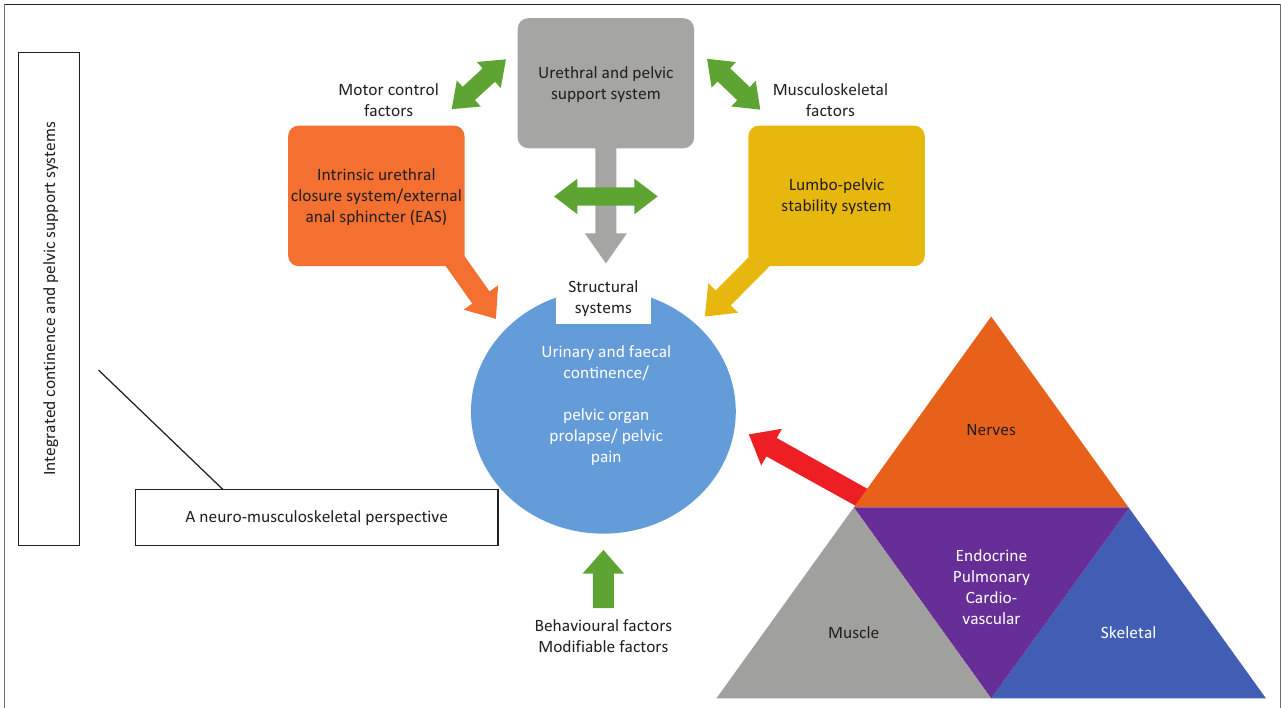
FIGURE 1: Interaction between the integrated pelvic support and continence mechanisms and the neuro-musculoskeletal